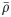
Phase behaviors of the branched multivalent systems for T* = 0.25.(a) Full phase diagram, where the purple line denotes the proxy for the binodal and the green line is the proxy for the percolation line (see also the caption for Fig 7). The phase-separated region has an elliptical shape and we have a closed loop, which demonstrates re-entrant phase behavior, whereas the percolation line has a conical shape extending into much higher densities. The solid black lines denote contours of constant total concentration where L1 is the lowest concentration and L3 is the highest concentration. Note that both axes are represented in the log scale. (b, c) ρ¯ and ϕc curves as a function of relative stoichiometric ratio of N130 and rpL5 along the constant-concentration contours. (d) Plot of Λ vs. the apparent stoichiometry along lines L1, L2, and L3.